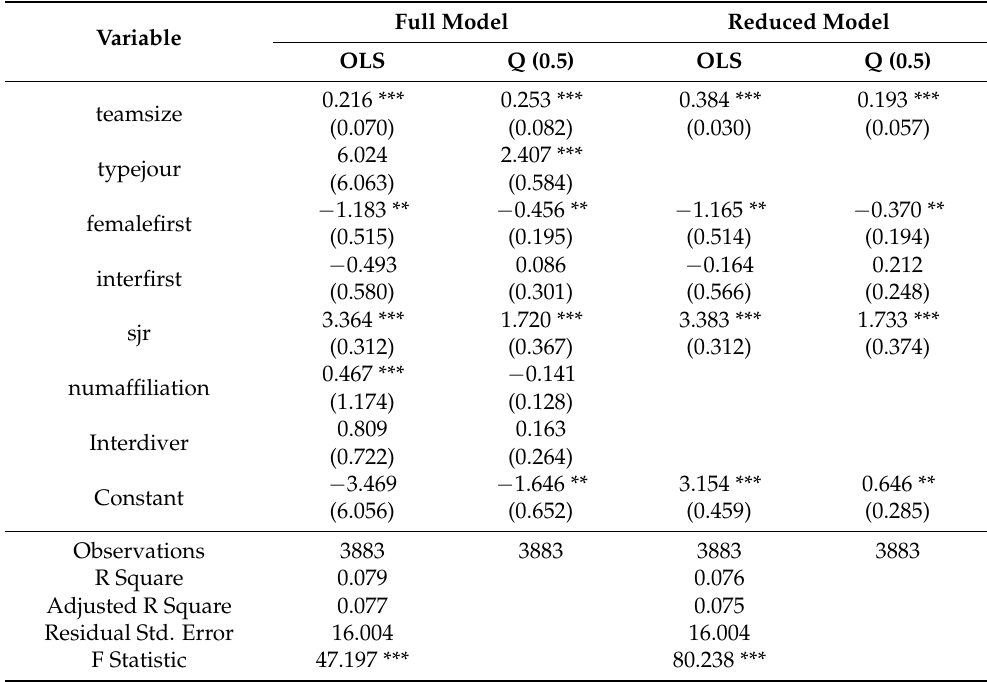
Table 7. The impact of authorship characteristics on citations considering OLS and quantile regression (0.5th